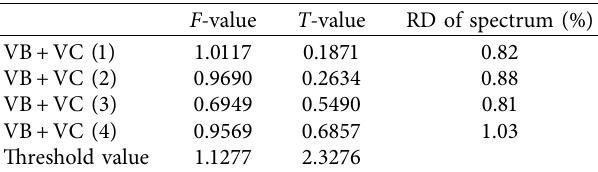
Table 3: RD, F -value, and T -value between the actual mixed spectra and simulated mixed spectra of the vitamin samples VB +VC (1) VB +VC